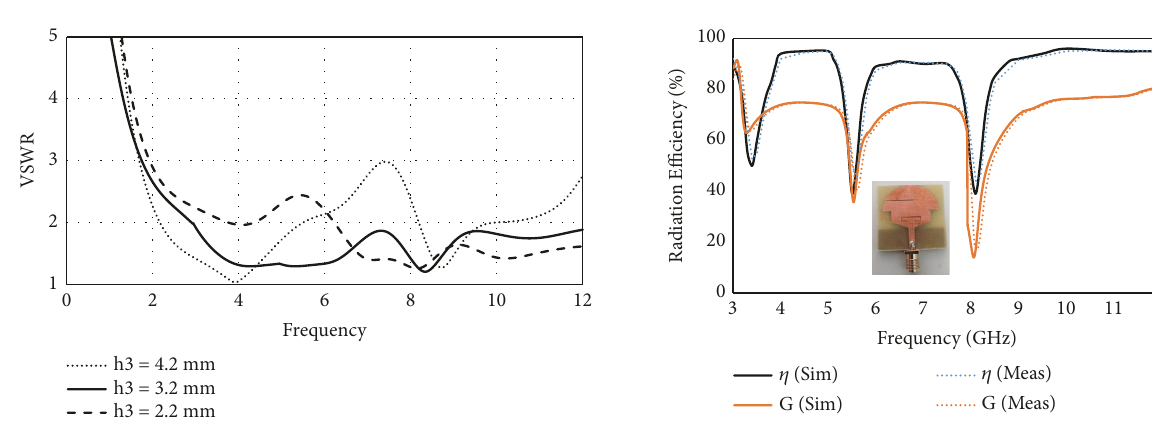
Figure 7: Simulated VSWR for various slot lengths ( L 2l + 2l + l , L = 2l + l ). 3 4 5 s3 1 2